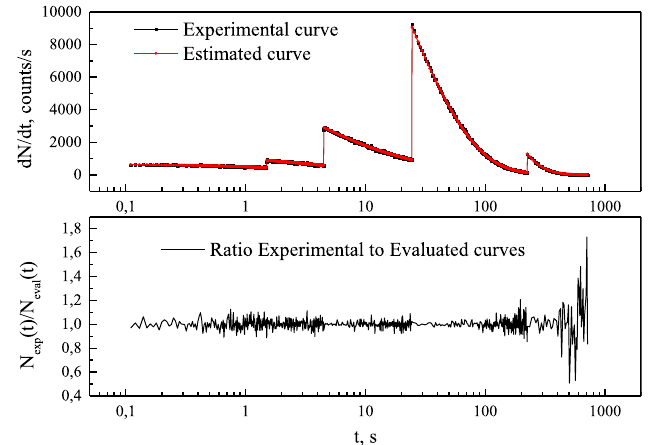
Fig. 3. Time dependence of the delayed neutron intensity. Squares (cid:1) experimental curve, circles (cid:1) curve estimated in the process of least square fi t. Lower graph shows the ratio of the experimental to evaluated